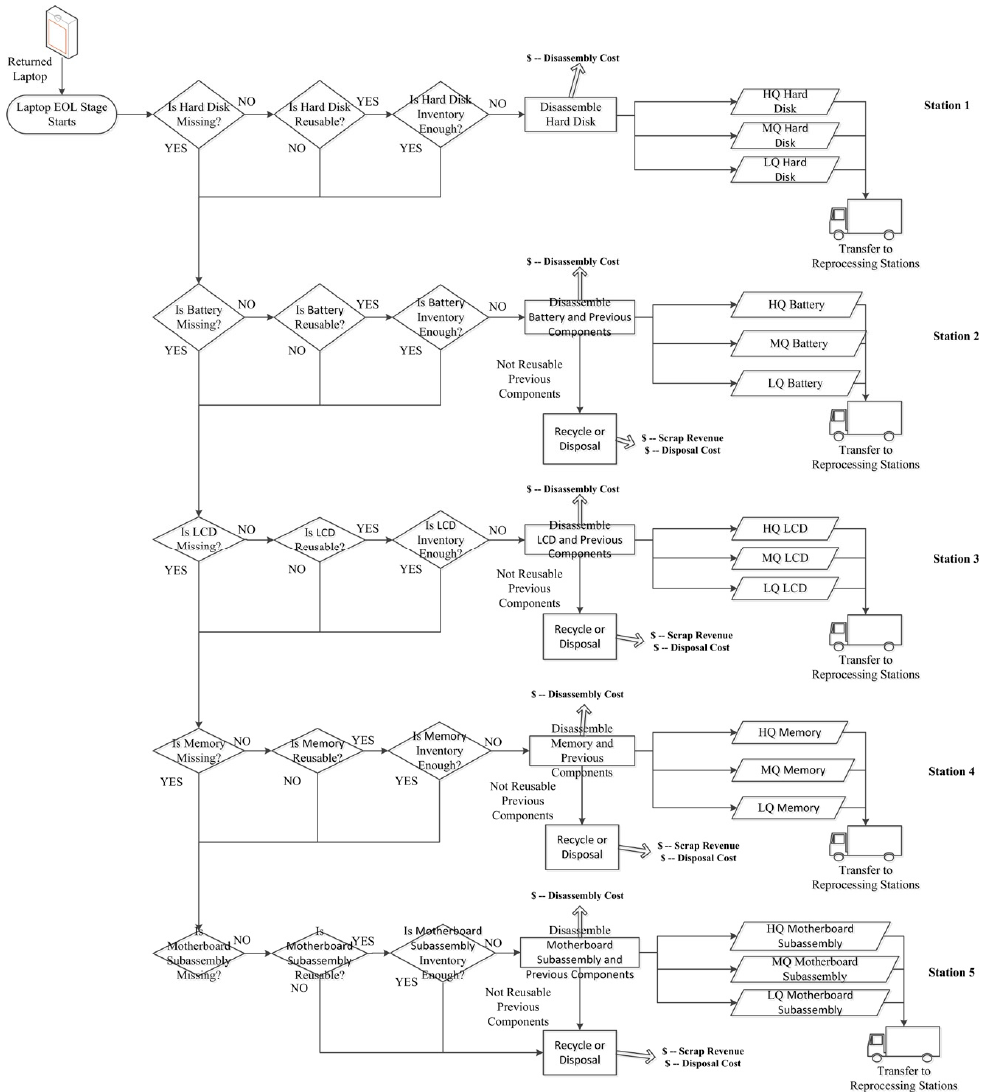
Figure 6. SEL systems disassembly and inspection processes.